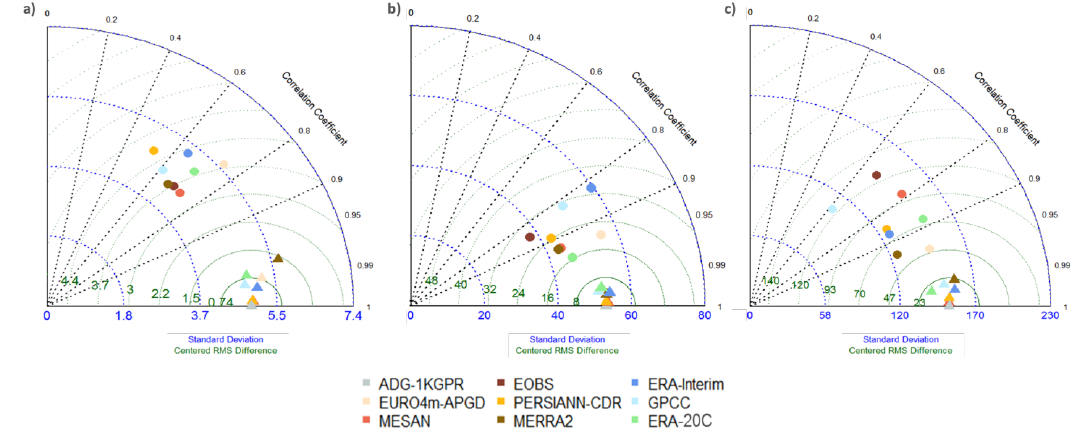
Figure 6. Taylor Diagram based on daily ( a ); monthly ( b ) and annual ( c ) catchment mean precipitation for the Adige catchment. Circles correspond to the gridded precipitation data sets, while triangles refer to aggregated reference grid.